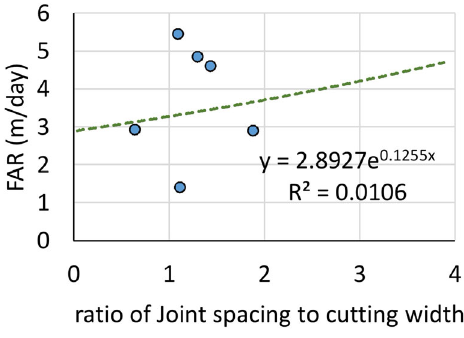
Fig. 11 Relationship between ratio of joint spacing to cutting depth and FAR, an exponential regression